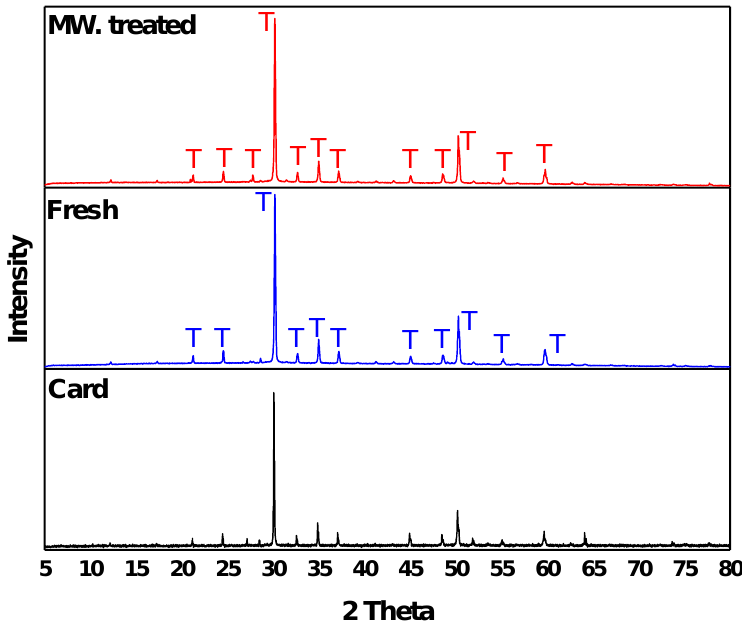
Figure 2. XRD patterns for fresh and microwave treated tennantite. T denotes tennantite.